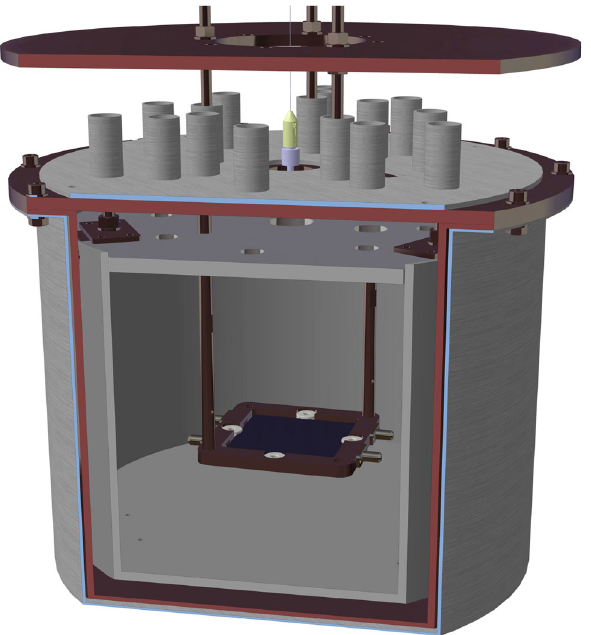
Fig. 3 Rendering of the shielding pot anchored to the 20 mK plate of the cryostat at the top. The pot consists of three concentric layers acting as magnetic and radiation shields. The outer one is made of Cryophy® formagneticshielding,themiddleoneofcopperforthermalization,and the inner one of aluminum for further magnetic and radiation shielding. The mechanical design of the parts constituting the assembly has been carried out considering the effect of the differential thermal contrac- tions related to the different materials constituting the system (copper, aluminum and Cryophy®). In this way, at cryogenic temperatures, the system has maintained minimum gaps without introducing unwanted mechanicalstressonthecomponents.The“chimneys”arefeedthroughs forcablesmadeofCryophy®aswell.Theopticalfiber,showninyellow, illuminatesthedetectorfromthetopandisconnectedontheotherendto a room temperature LED (not shown in the figure). The detector frame